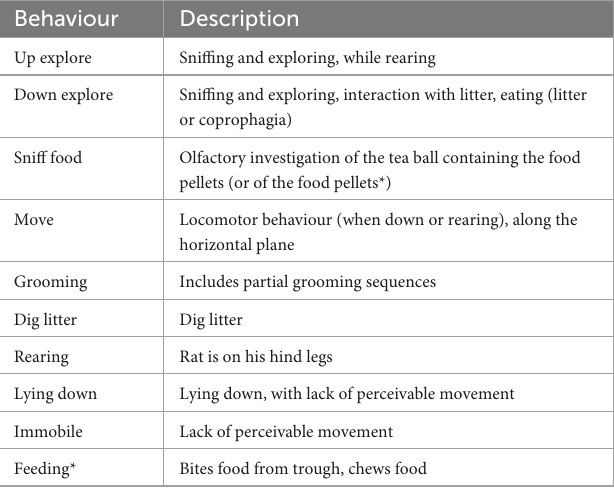
TABLE 1 Ethogram for behaviours detected in the scan sampling study of the anticipatory and consummatory meal phases (*only in the test meal phase) those behaviours are mutually exclusive.